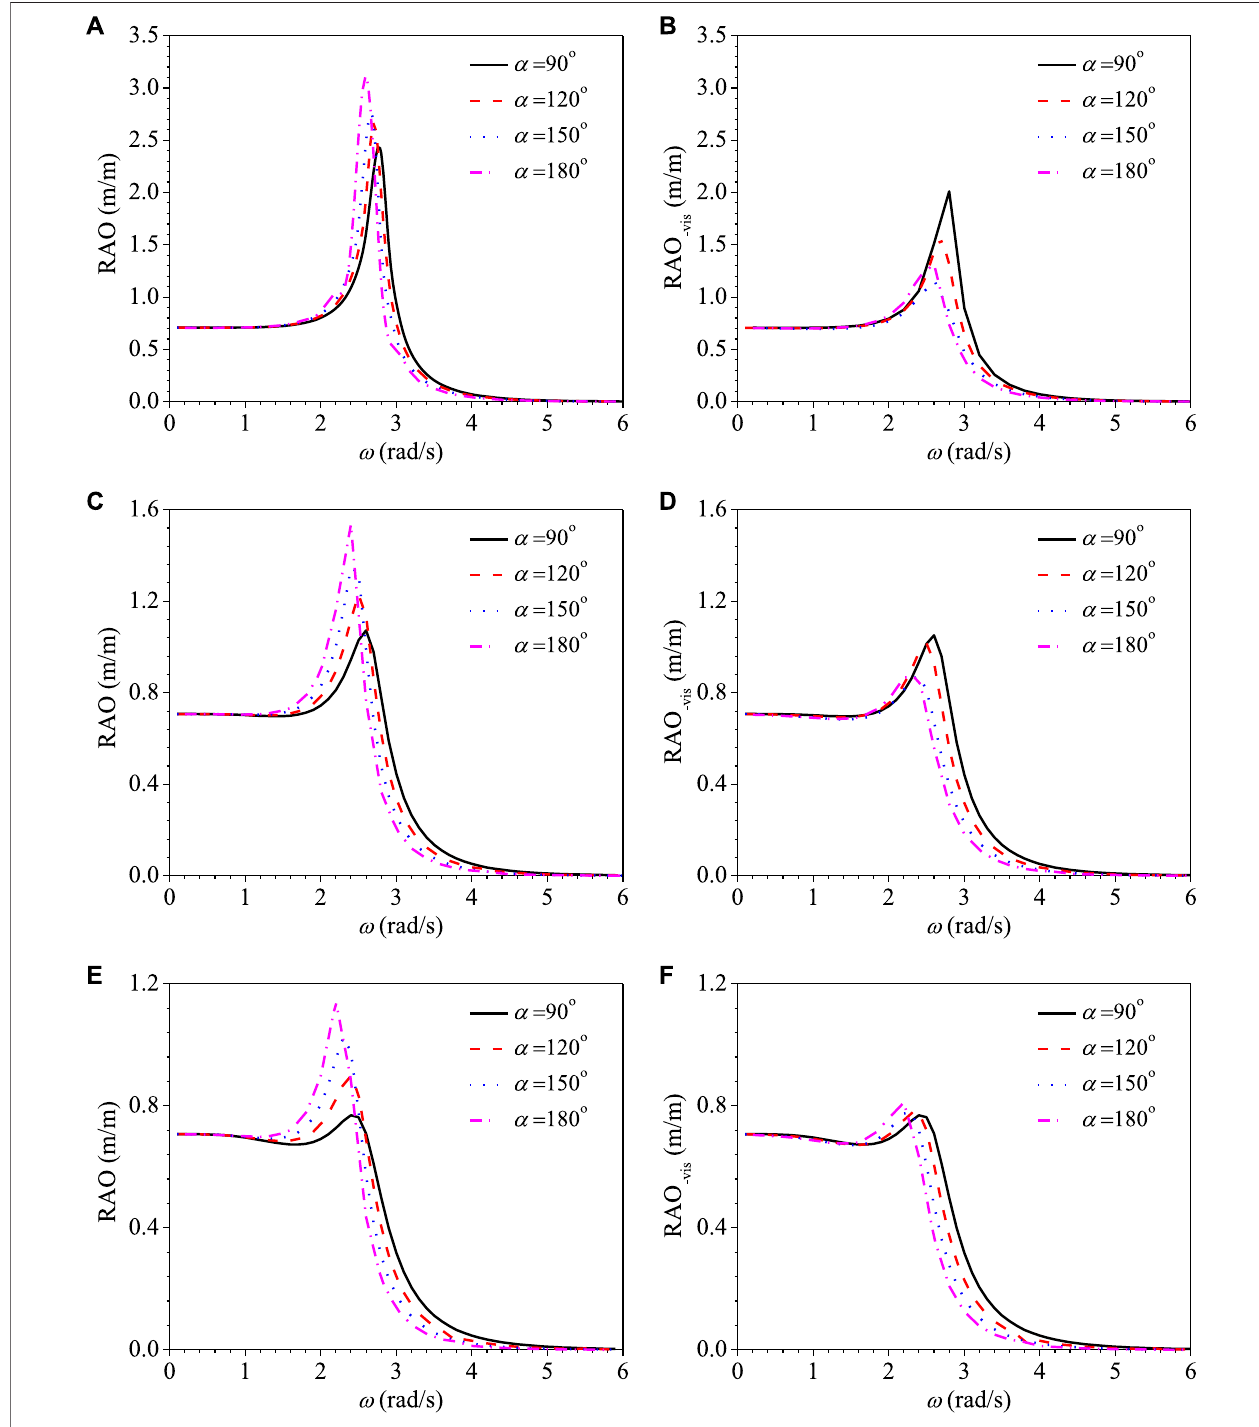
FIGURE 4 | Variations of RAO vs. ω for the cone bottom cylindrical WEC with different 2 r / d . (A) RAO at 2 r / d (cid:2) 1.6, (B) RAO -vis at 2 r / d (cid:2) 1.6, (C) RAO at 2 r / d (cid:2) 2.8, (D) RAO -vis at 2 r / d (cid:2) 2.8, (E) RAO at 2 r / d (cid:2) 3.6, and (F) RAO -vis at 2 r / d (cid:2) 3.6.